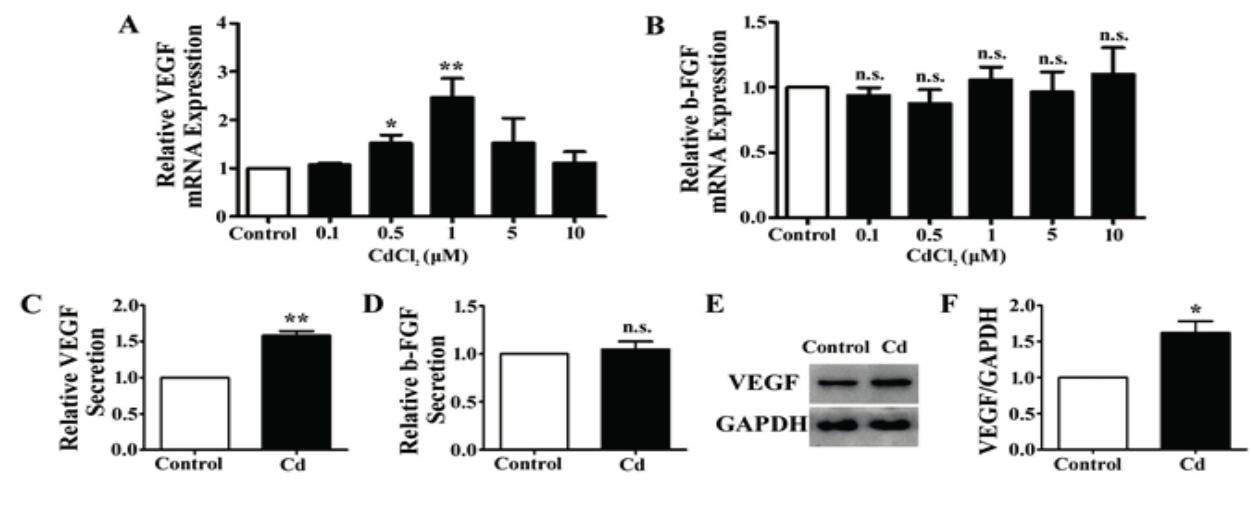
Figure 2. The effects of Cd on VEGF and b-FGF expression in A549 cells. ( A ) Relative VEGF mRNA expression in A549 cells treated with CdCl 2 for 24 h by qRT-PCR. n = 4; n.s., non-significant; * , p < 0.05; ** , p < 0.01. ( B ) Relative b-FGF mRNA expression in A549 cells treated with CdCl 2 for 24 h by qRT-PCR. n = 4; n.s., non-significant. ( C ) Relative